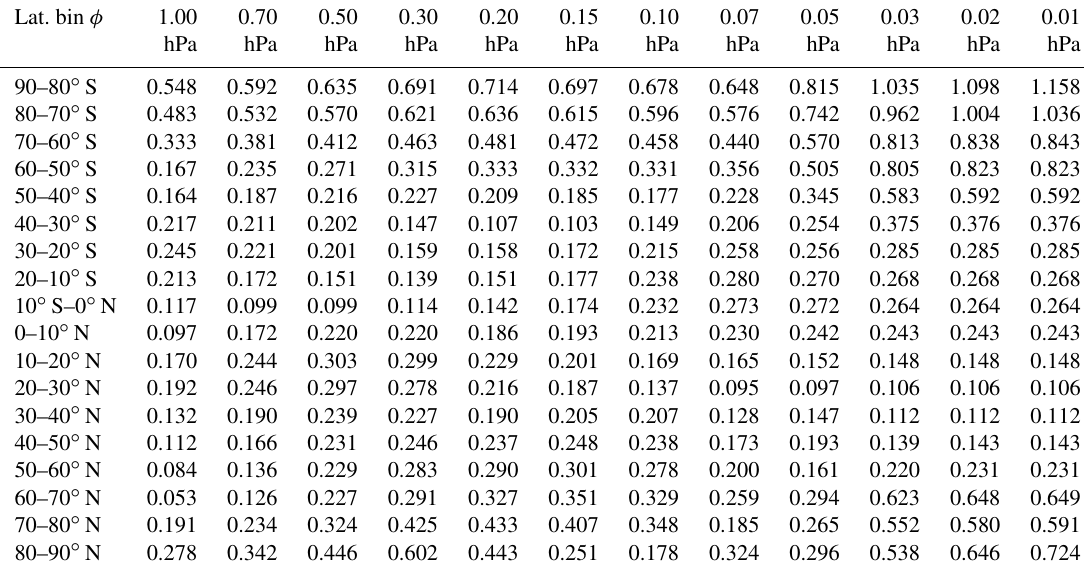
Table B2. Coefficients a 1 (φ,z)